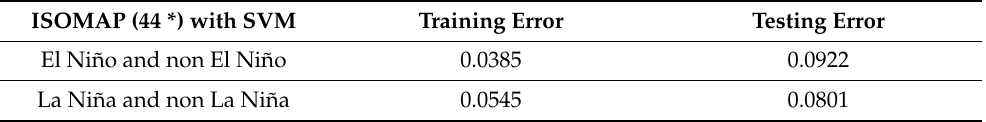
Table 2. The training errors and the testing errors from the 20-dimensionality ISOMAP with